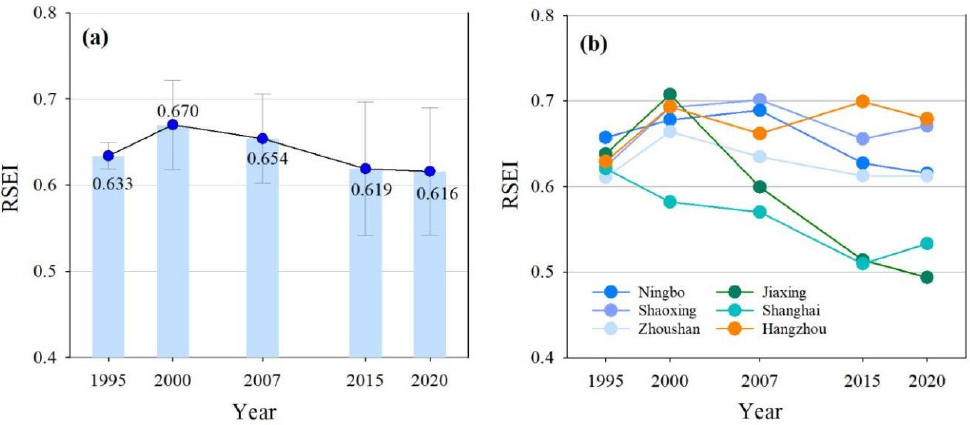
Figure 5. RSEI changes in the HGBA during 1995–2020: ( a ) the overall RSEI change; ( b ) the RSEI changes for each prefecture-level city.